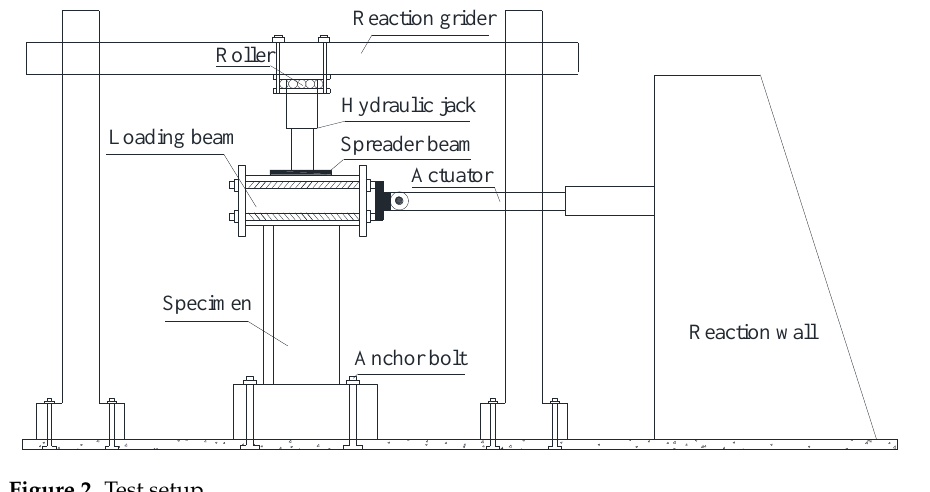
Figure 2. Test setup.